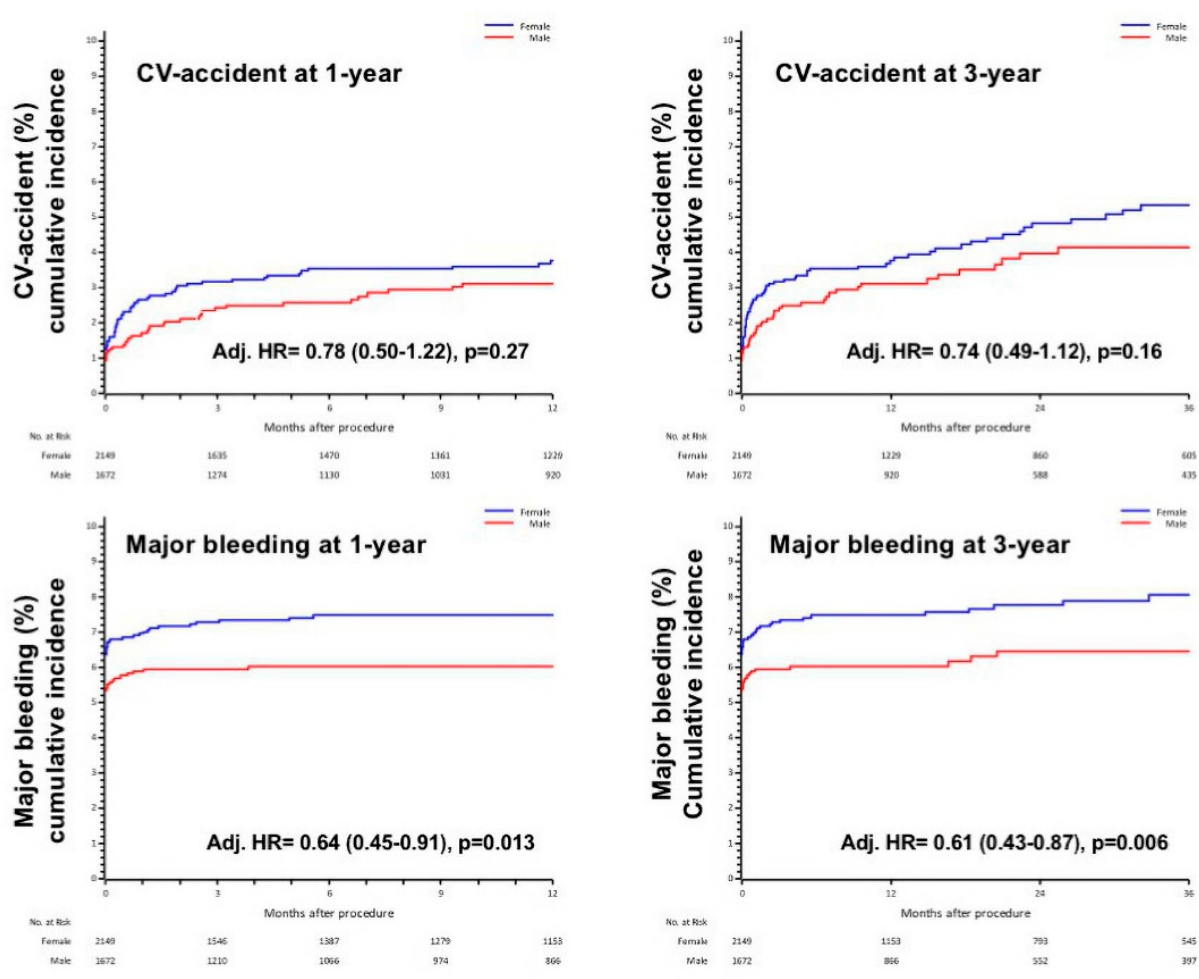
Figure 5. 1-year and 3-year stroke and bleeding in male and female, adjusted respectively for age and eGFR, and for age, CAD, MI and PAD.